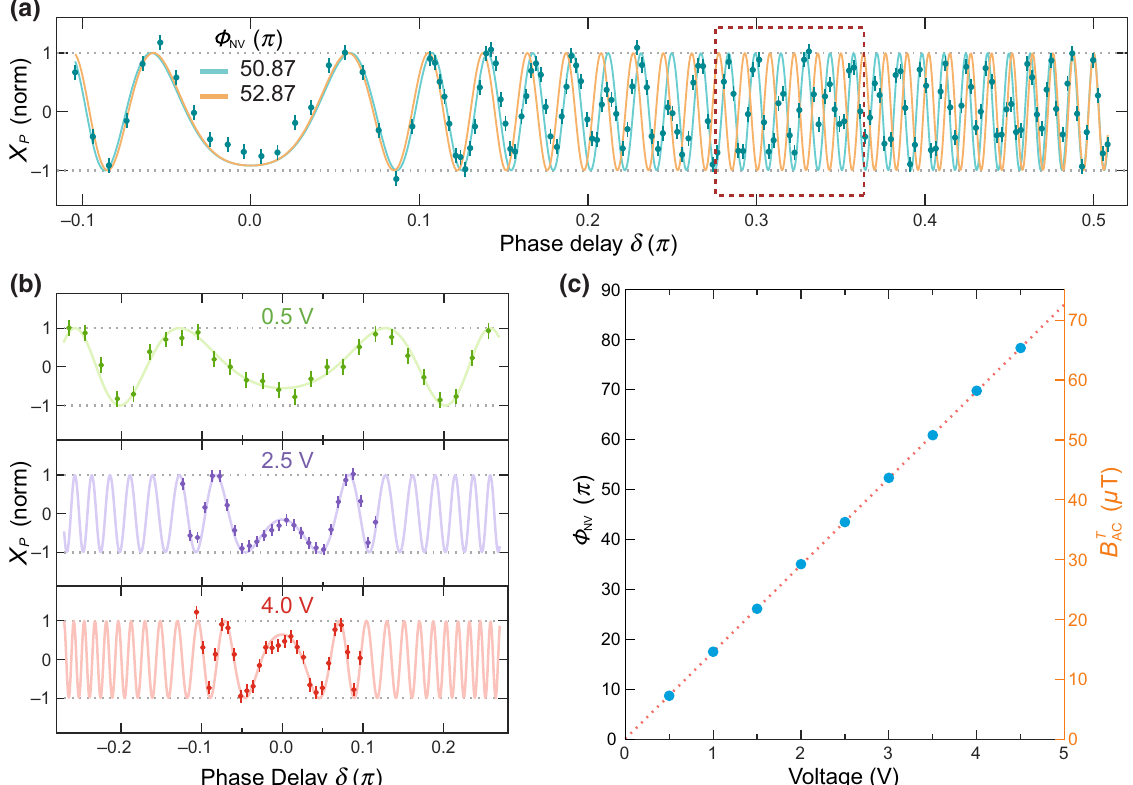
FIG. 10. Determining the absolute magnitude of (cid:16) NV . (a) Full fringe pattern of X P (δ) (teal markers) and its best fit curve (teal line). The expected behavior of X P (δ) for (cid:16) NV offset by 2 π is also plotted (orange line), showing disagreement with the data in the boxed region. (b) The X P (δ) curves for increasing amplitudes of the coil field (controlled by the voltage applied to the coil). (c) Fitted (cid:16) NV versus coil voltage shows a precise linear dependence and confirms the correct assignment of the 2 π branch for each